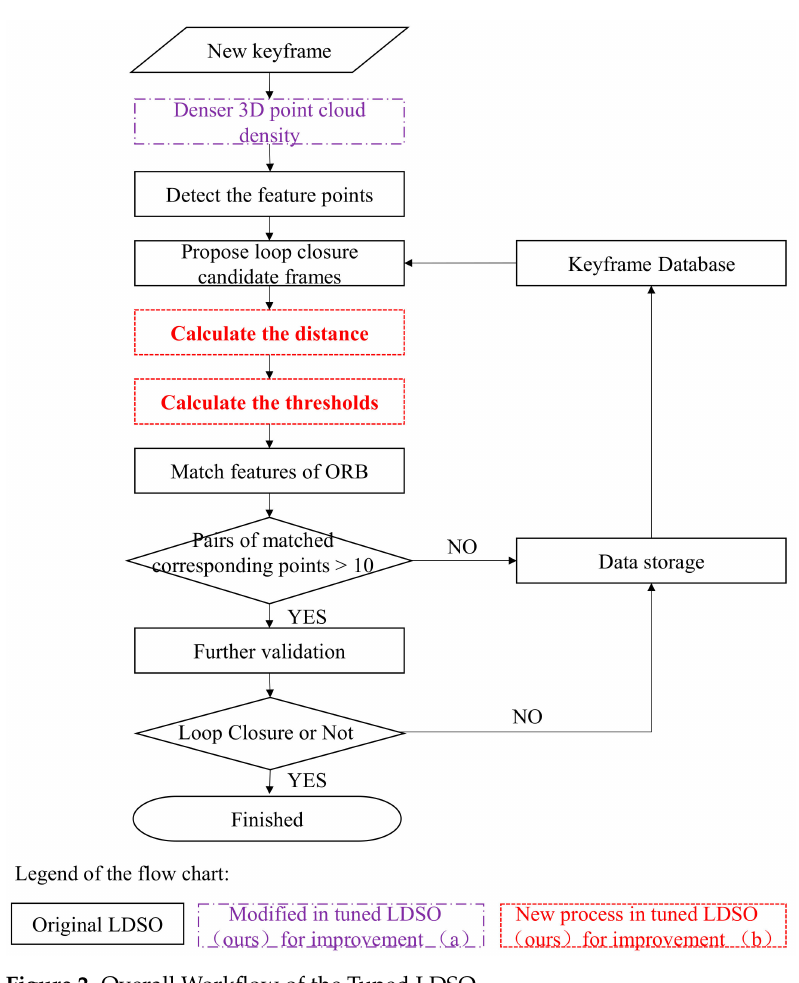
Figure 2. Overall Workflow of the Tuned